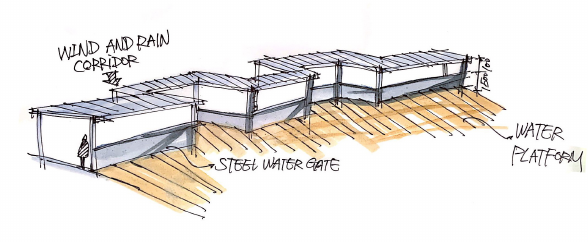
Fig. 9 Sketch of the design concept of